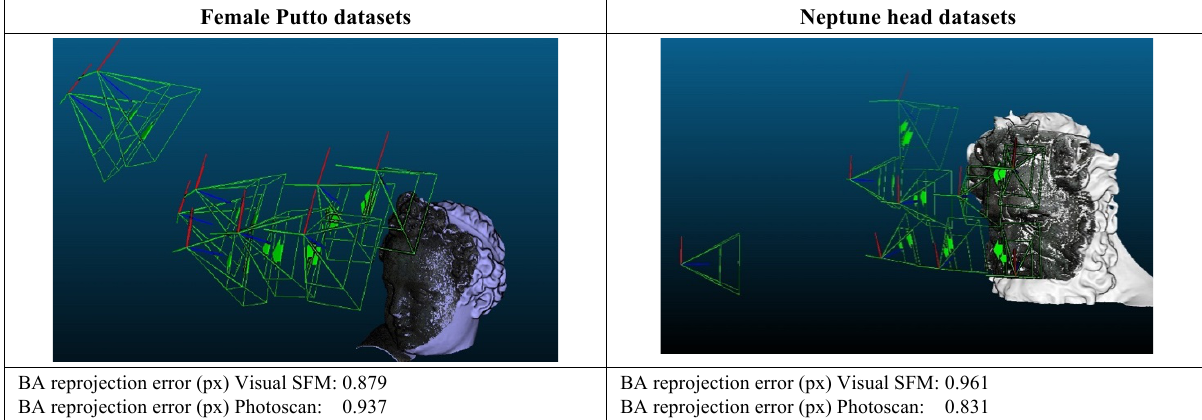
Figure 8. Camera alignment of female Putto (r) and Neptune head (l) datasets (9 images) comparison and Bundle Adjustment